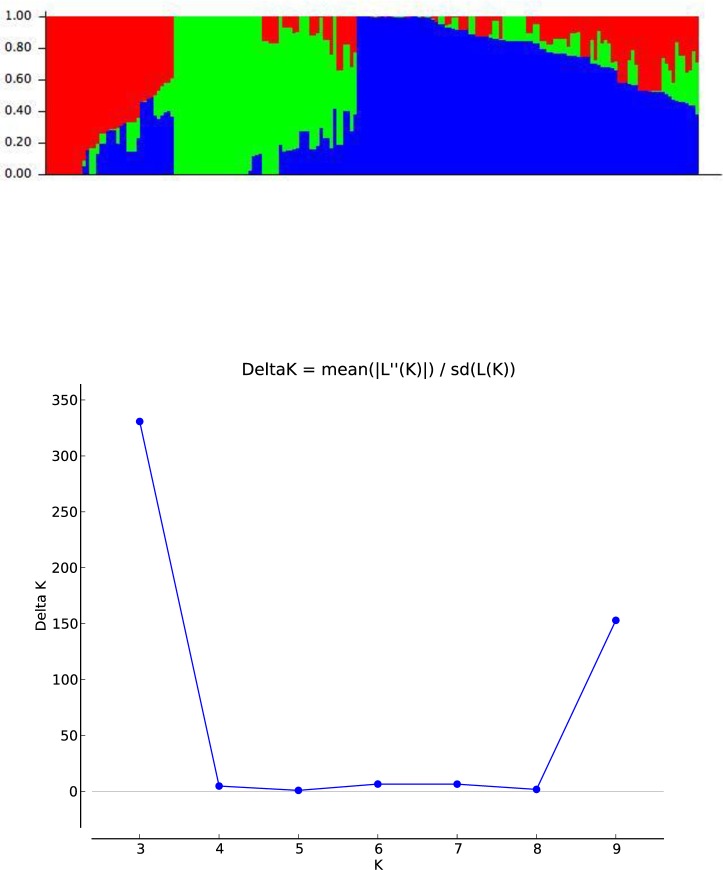
STRUCTURE analysis used to define genetic relationships in the AM panel.a) Each horizontal entry represents one AM panel entry. The existence of three sub-populations was inferred. b) Δk plot, with k ranging from1-10.